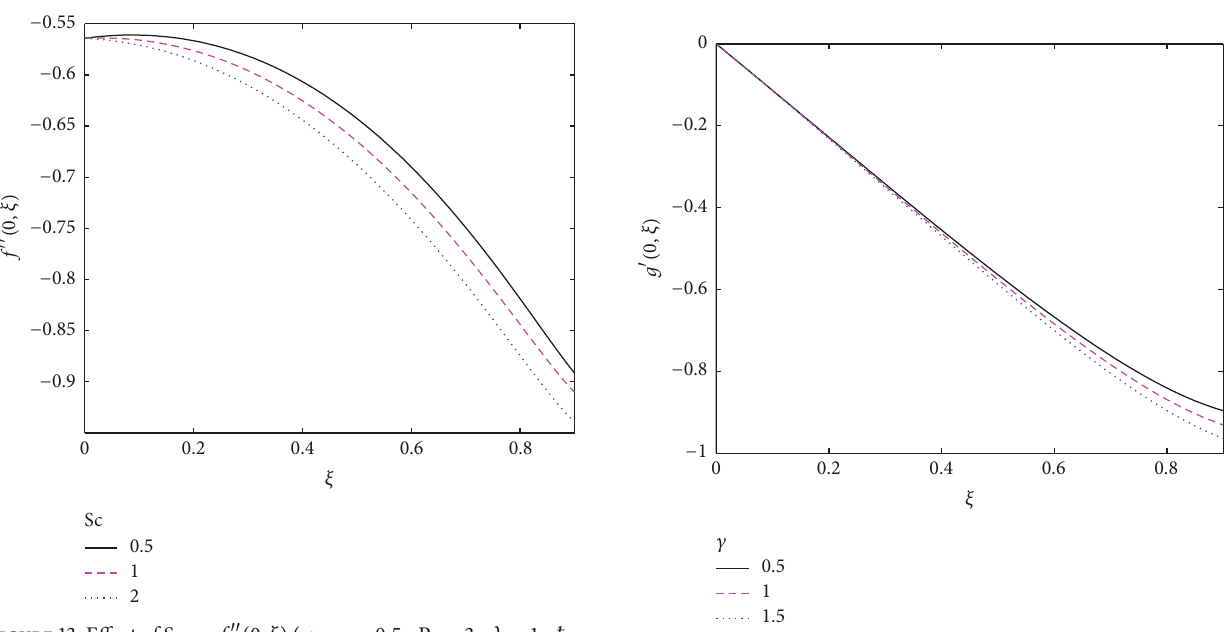
Figure 15: Effect of 𝛾 on 𝑔 󸀠 (0,𝜉) ( 𝜎 = 0.5, 𝜆 = 1, Pr = 3, Sc = 2, ℏ = −0.5